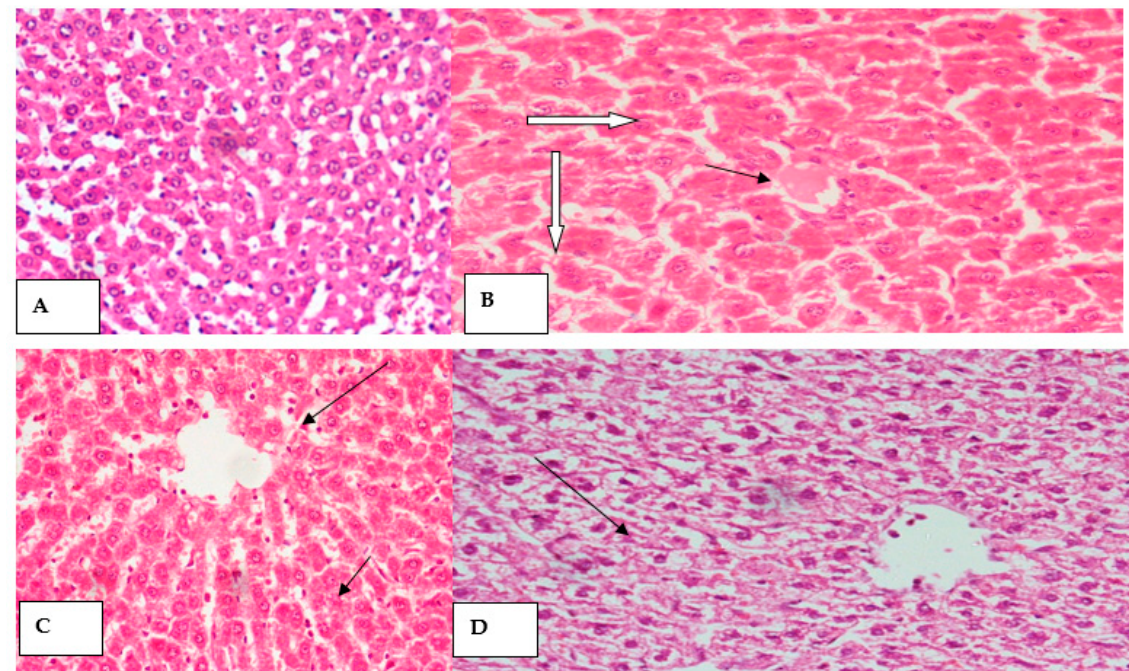
Figure 5. ( A ). Liver tissue of control rat showing cords of ordinary hepatocytes with sinusoids in between. ( B ). Liver tissue of diabetic untreated rat showing marked vacuolar and hydropic degeneration (white arrows) within hepatocytes with focal oedema (thin black arrow). ( C ). Liver tissue of diabetic rat treated with reference drug showing preserved architecture with ordinary hepatocytes showing minimal residual micro vesicular degeneration (thin black arrow S). ( D ). Liver tissue of diabetic rat treated with (compound 5 ) showing hepatocytes with hydropic degeneration (thin black arrow) (H&E ×400).